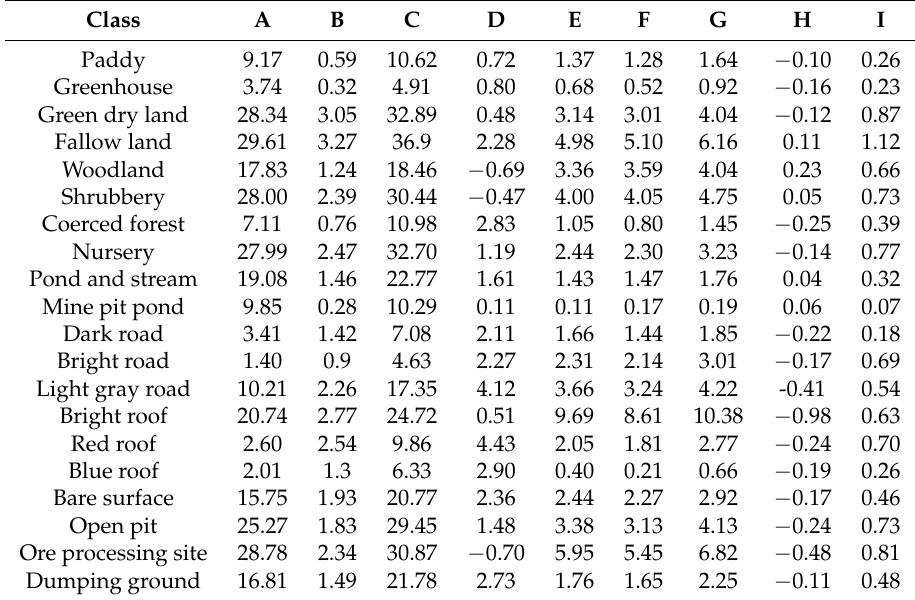
Table 10. The percentage deviation values (%) of F1-measures for different land covers obtained between different classification models. RF: random forest. SVM: support vector machine. FS-RF: RF with feature selection (FS) method. FS-SVM: SVM with FS method. DBN-S: deep belief network (DBN) with softmax classifier. DBN-RF: the fused model of DBN and RF. DBN-SVM: the fused model of DBN and SVM. A – I: RF vs. SVM, FS-RF vs. RF, FS-SVM vs. SVM, FS-SVM vs. FS-RF, DBN-S vs. FS-SVM, DBN-RF vs. FS-SVM, DBN-SVM vs. FS-SVM, DBN-RF vs. DBN-S, and DBN-SVM vs. DBN-S,